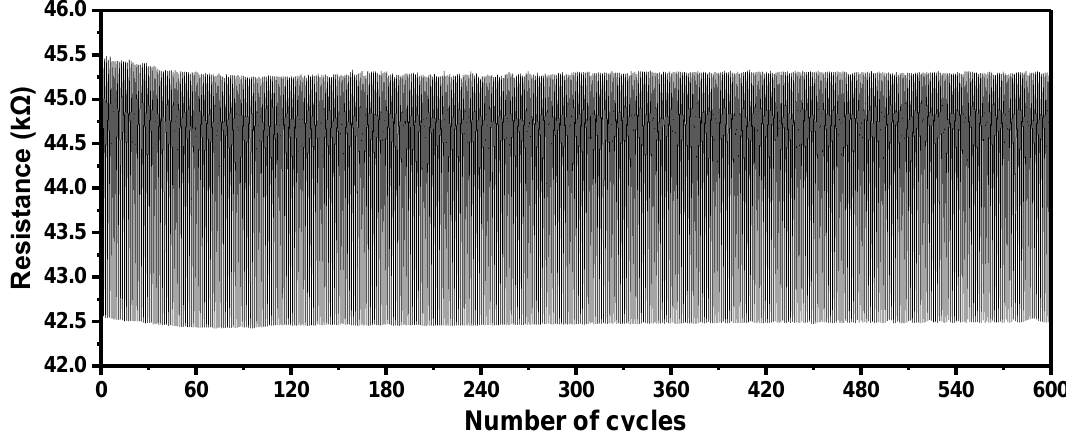
Figure 9. Mechanical stability test of the strain sensor under 600 loading-unloading cycles of a 5.6% bending strain.